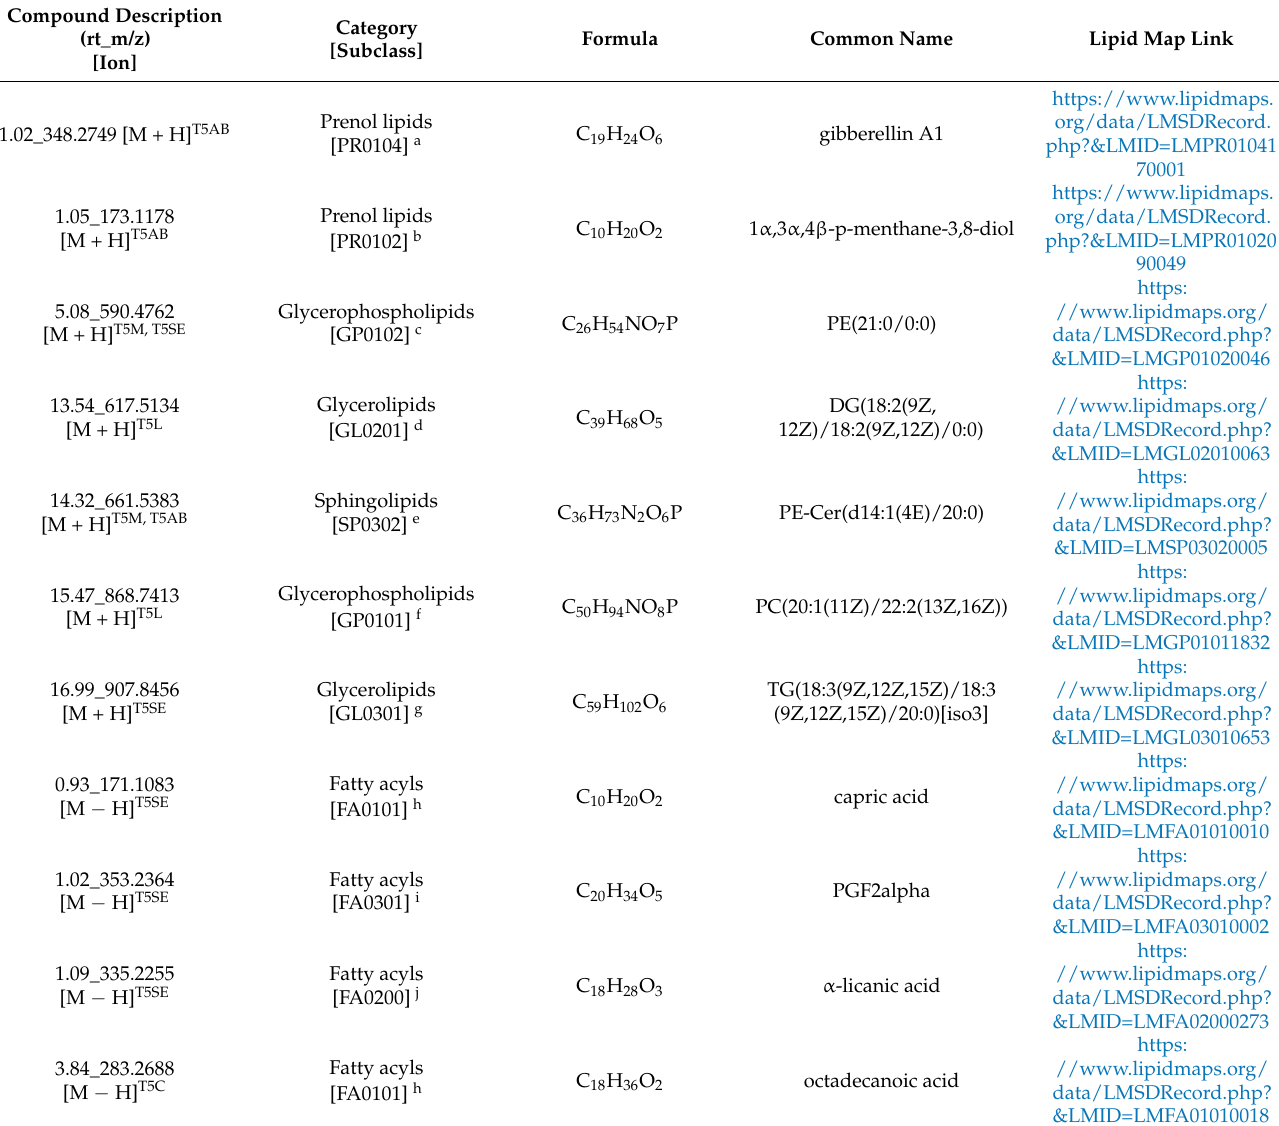
The superscription after [ion] indicates in which table or figure the significance is shown. T4C : Table 4 Cognitive; T4L : Table 4 Language; T4M : Table 4 Motor; T4SE : Table 4 Social–emotional; T4AB : Table 4 Adaptive behavior; a [PR0104]: C20 isoprenoids (diterpenes); b [PR0102]: C10 isoprenoids (monoterpenes); c [GP0102]: 1-alkyl,2-acylglycerophosphocholines; d [GL0201]: Diacylglycerols;